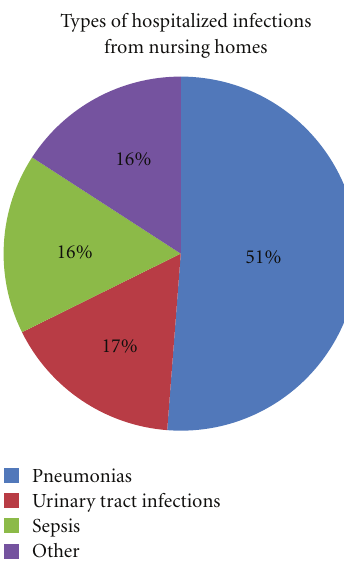
Figure 4: Types of infections on admission from nursing home to hospital in Bergen, Norway, during the period from March 2006 to March 2007 ( N = 328).